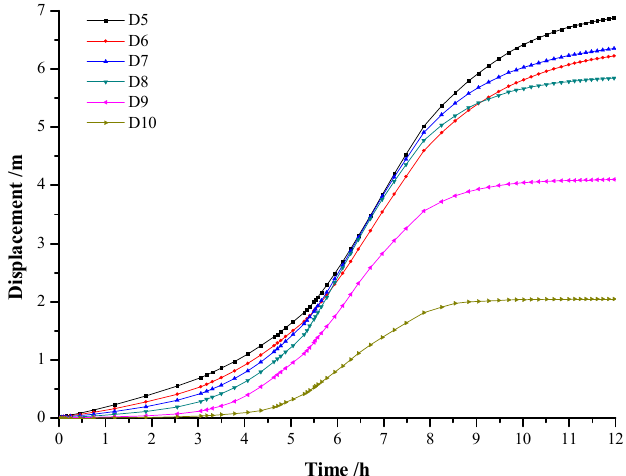
Figure 18. Variation of slope displacement with time.